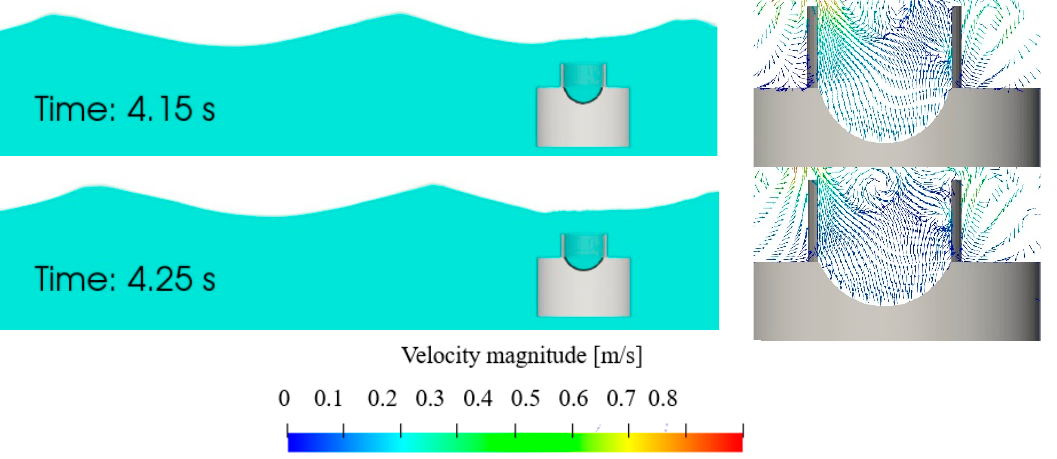
Figure 14. The evolution of the waves and fWEC response at different sampling times for M4, showing wave elevation ( left ) and zoomed-in view around the fWEC with velocity vectors ( right ). The time history of the tip displacements for the linear-elastic, hyper-elastic M3, and M4 materials is shown in Figure 15. For the linear-elastic membrane and hyper-elastic M3 membrane, their initial equilibrium positions ( δ static ) were similar under hydrostatic pressure. When waves propagated, although all three oscillated periodically with the same period as the waves, the motion of the M4 material was the largest among the three. The typical amplitudes were 0.0025 m for the linear-elastic material but 0.01 m for M3 and 0.0156 m for M4.